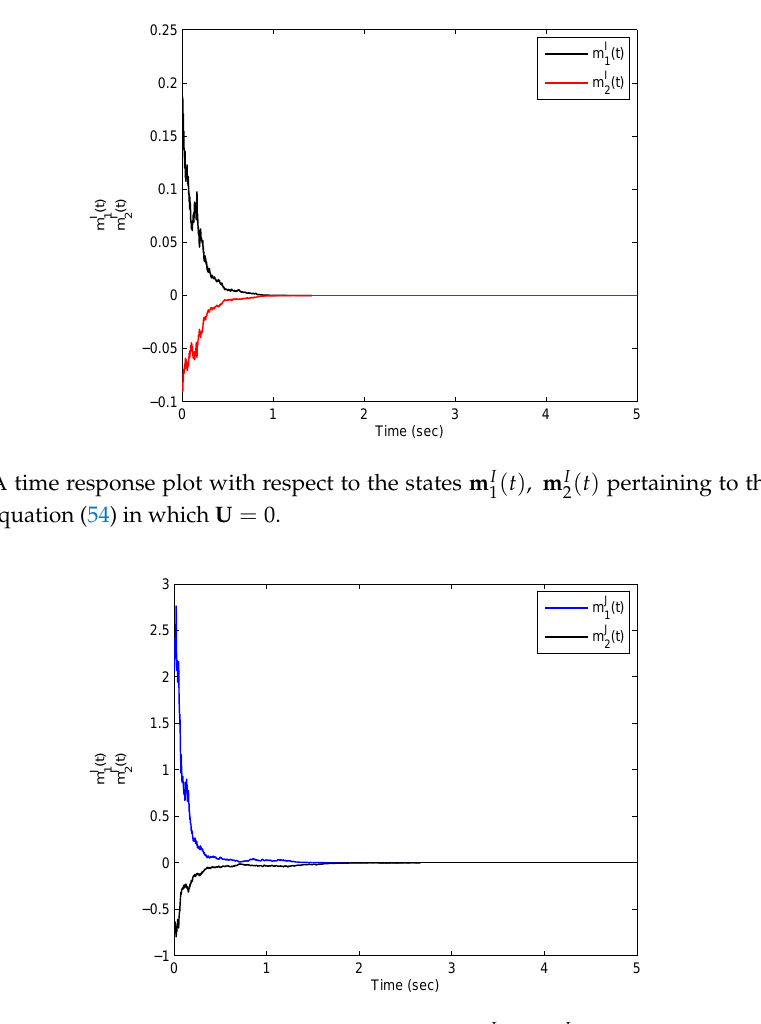
Figure 7. A time response plot with respect to the states m J model in Equation (54) in which U = 0.